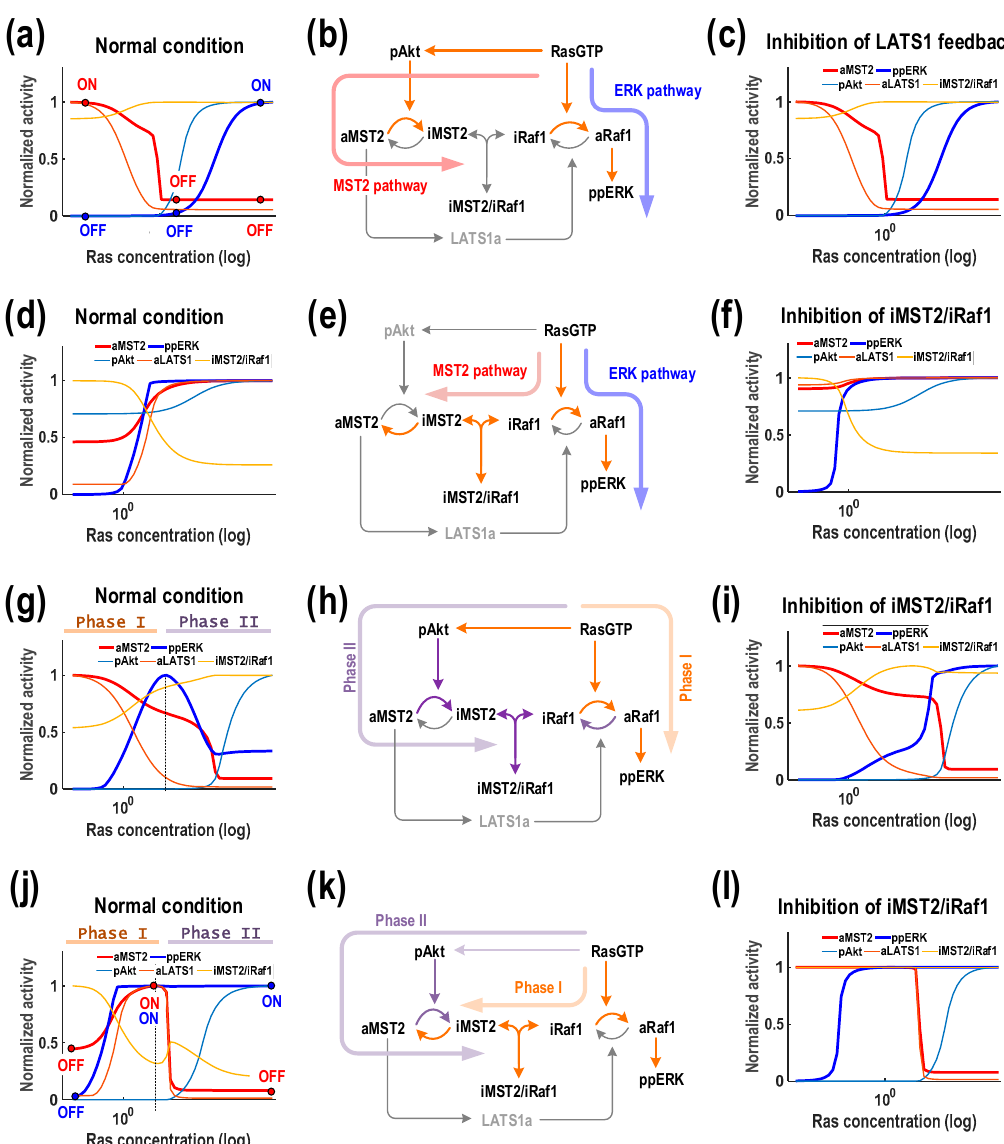
Figure 6. Ras displays multi-functional role. ( a – c ) The pattern M 1 E 2 where increasing Ras